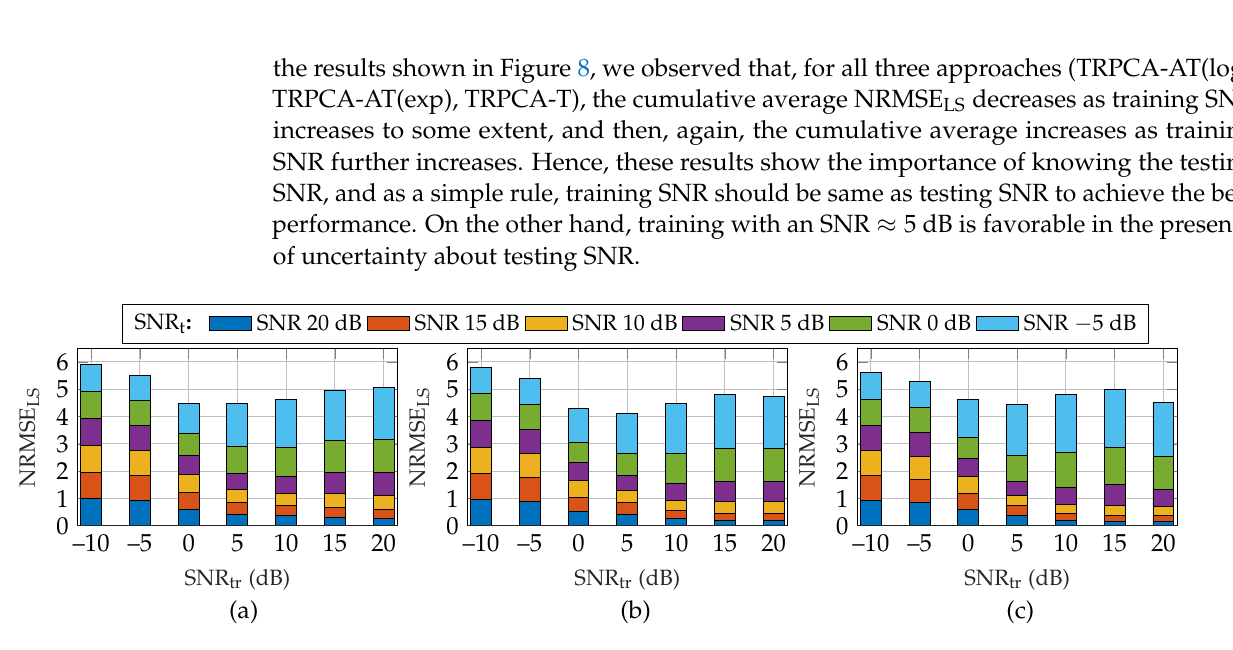
Figure 8. Average combined recovery error of low-rank and sparse matrices for compression ratio K / MN = 50% for training at a single SNR and testing with different SNRs for ( a ) ADMM-based trained RPCA with thresholding (TRPCA-T), ( b ) the proposed ADMM-based trained RPCA with adaptive thresholding based on logarithm heuristic (TRPCA-AT(log)), and ( c ) the proposed ADMM- based trained RPCA with adaptive thresholding based on exponential heuristic (TRPCA-AT(exp)). In the presence of uncertainty about testing SNR, then training with an SNR ≈ 5 dB is